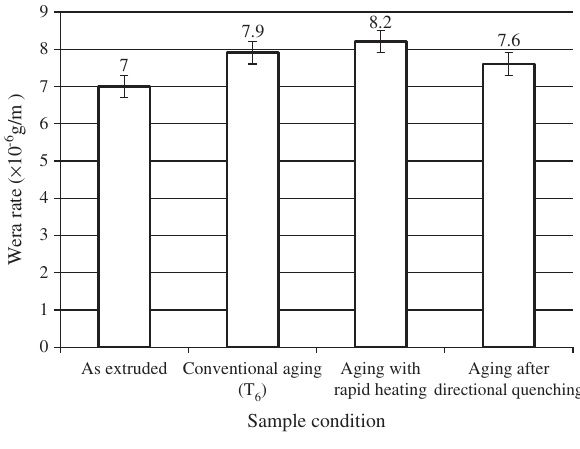
composite under p